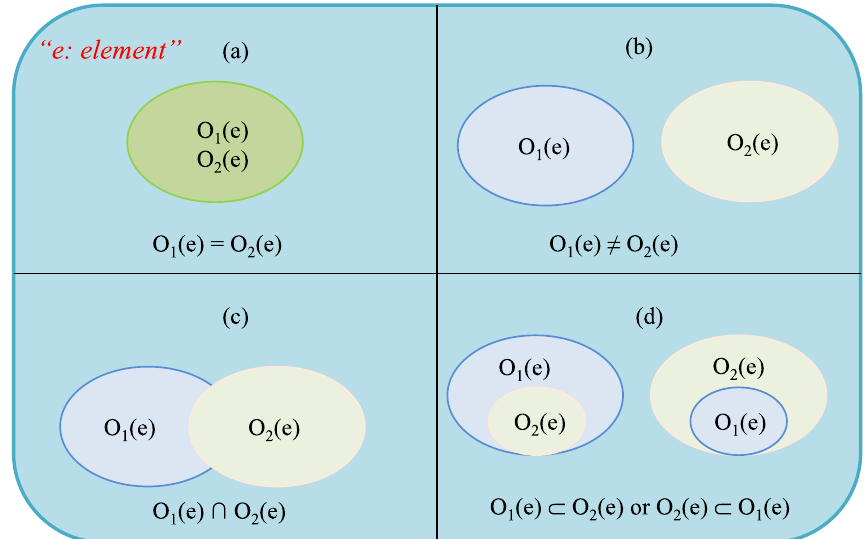
Fig. 3 The relationship between two elements O 1(e) and O 2(e) with different cases of a having the same object, b having different objects, c having an intersection relation, and d having a subspace in each